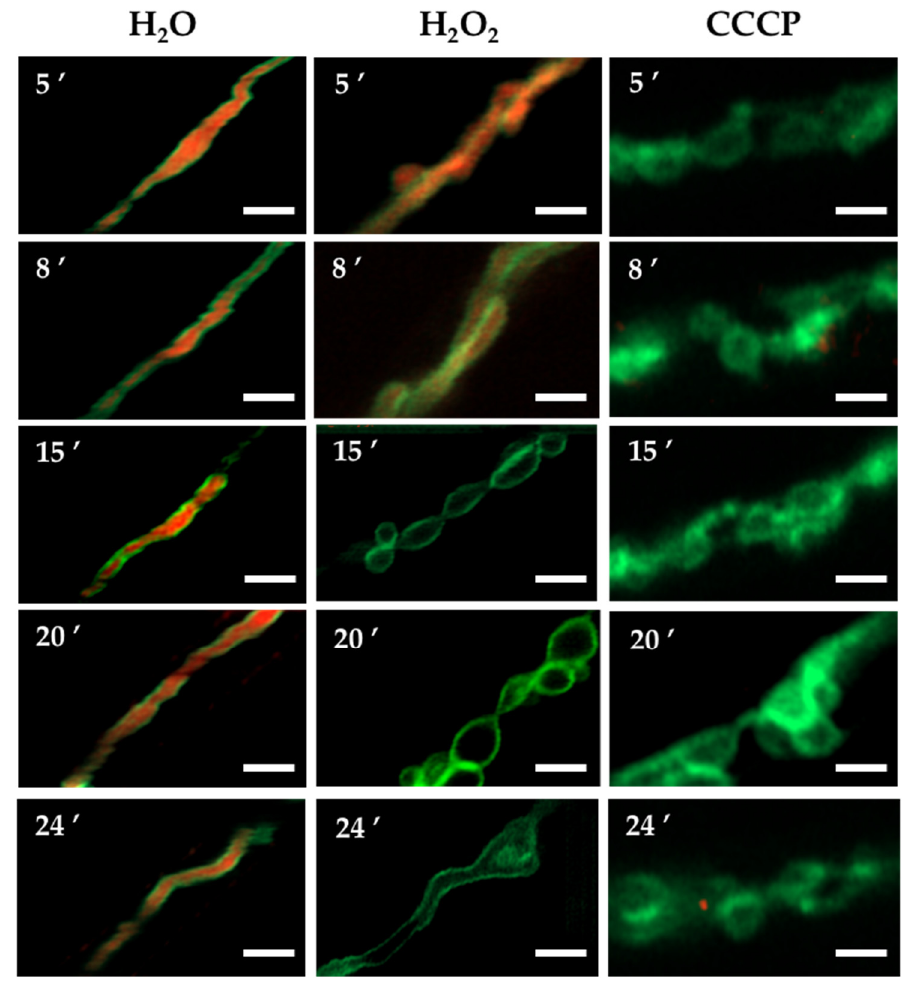
Figure 3. H 2 O 2 induces a gradual depolarization of the mitochondria before extensive mitochondrial constrictions are observed. Mycelia from Δ dnmA tom20::gfp strain CVG48 were grown for 18 h at 37 °C and stained with 100 µM TMRM for 20 min. After this, samples were rinsed three times with distilled water and then treated or not with 5 mM H 2 O 2 or 10 µM CCCP for another 20 min, rinsed, and immediately observed using Airyscan microscopy. The red florescence signal corresponds to TMRM-stained mitochondria, and the green signal corresponds to GFP-labelled mitochondrial outer membrane. Scale bar = 2 µm.